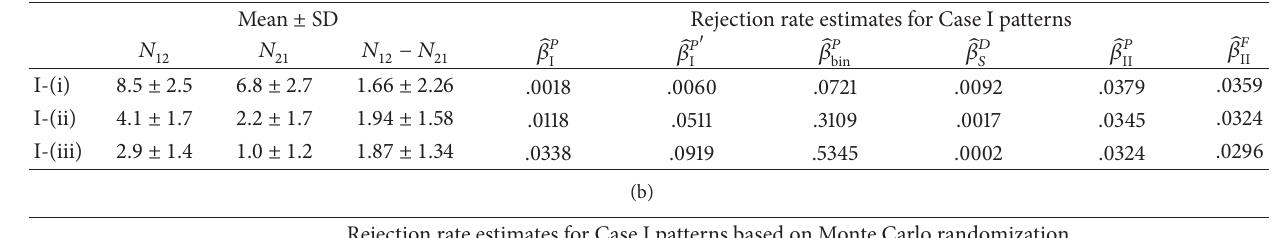
= 1000 generated mc ̂𝛽 𝐹 stands II